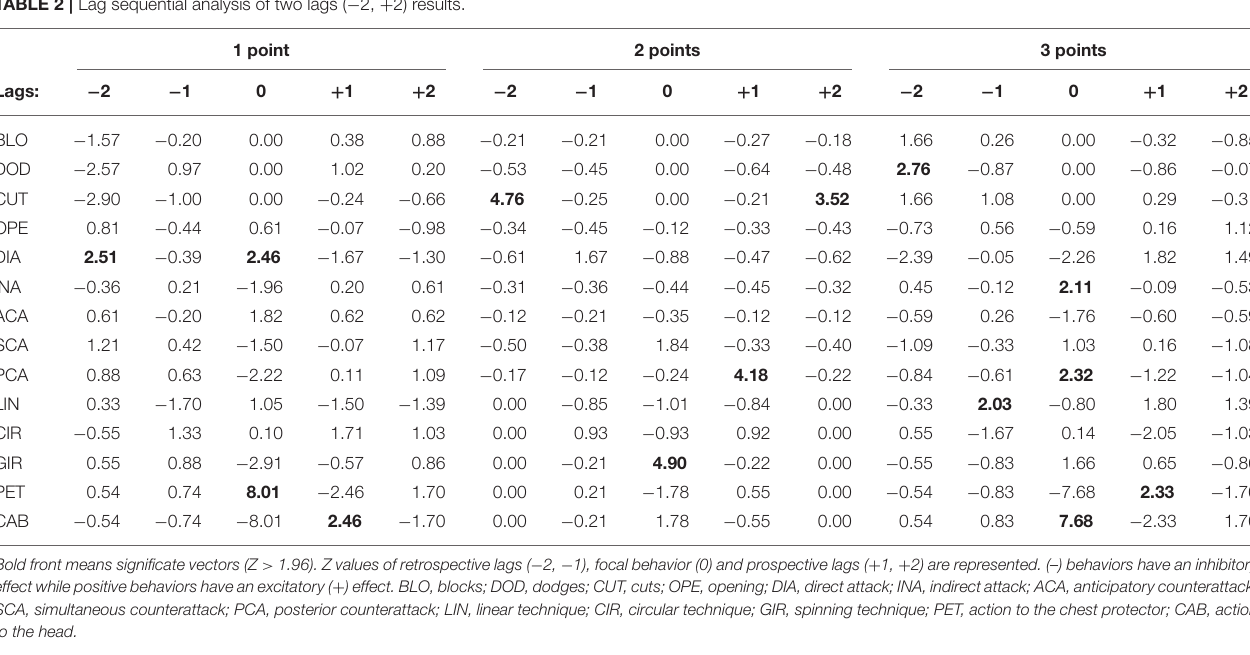
TABLE 2 | Lag sequential analysis of two lags (